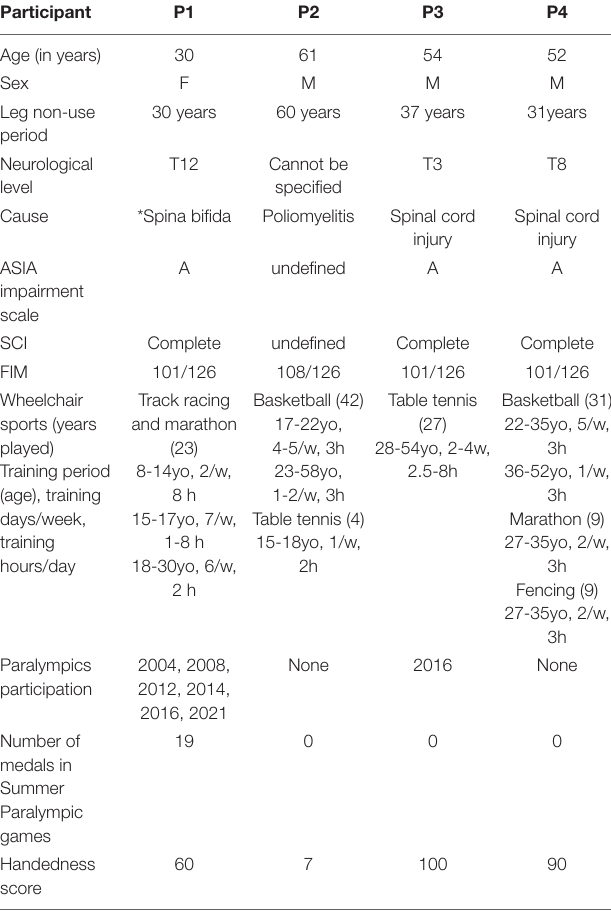
*Congenital. ASIA, American Spinal Injury Association; SCI, Spinal Cord Injury; FIM, Functional Independence Measurement; T, thoracic; yo, years old; w, week; h, hours.